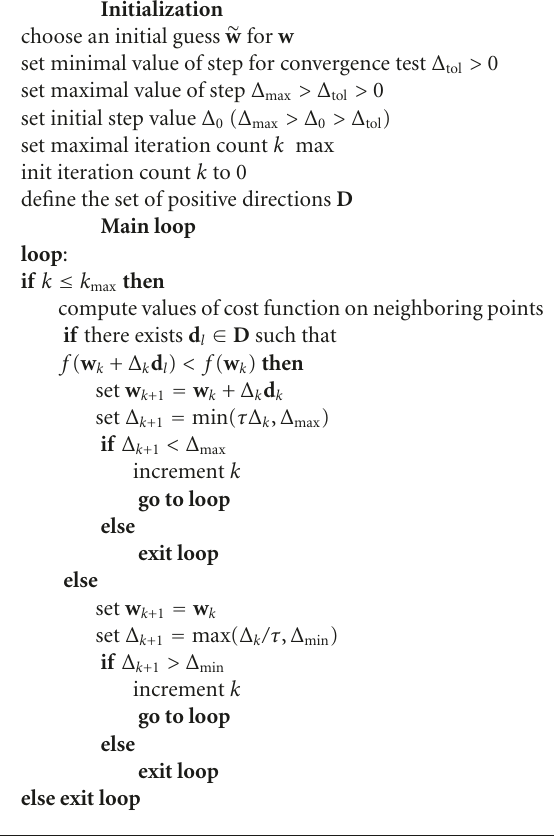
Algorithm 1: The algorithm for GPS